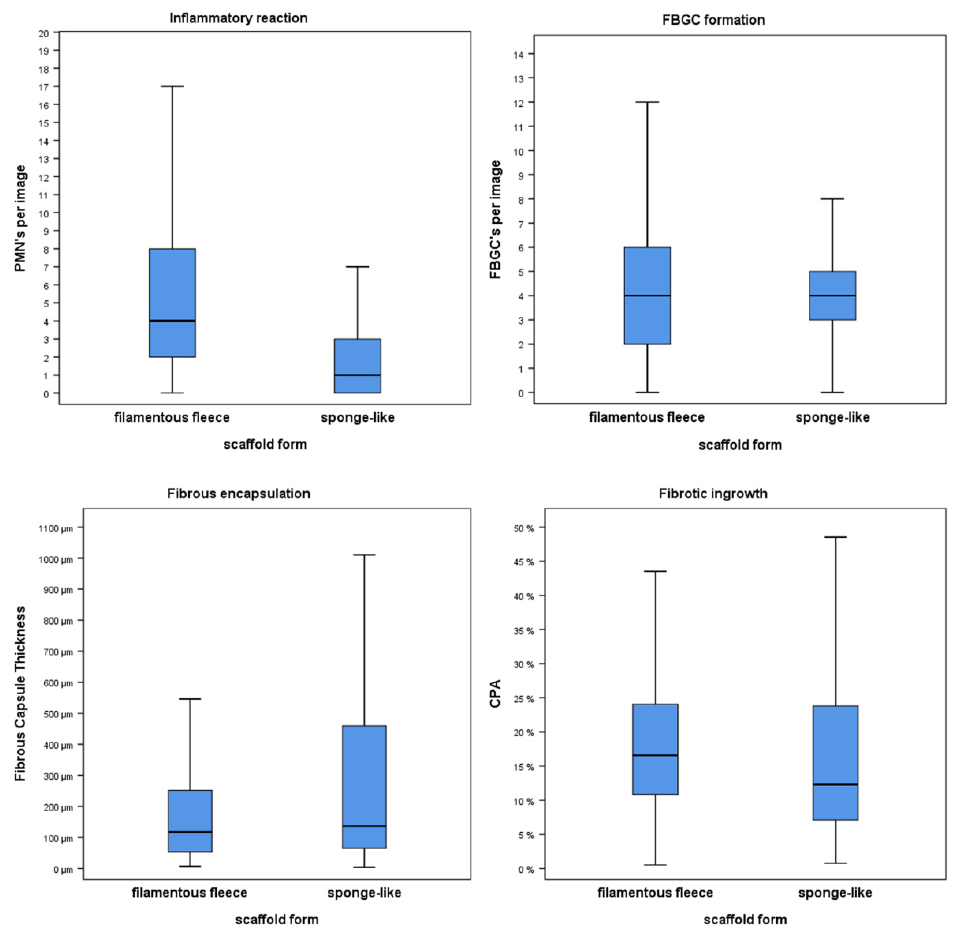
Figure 7. Results of the histopathological comparison between filamentous fleece and sponge-like biomaterial matrices (=scaffolds): variables of the FBR (PMNs, FBGCs, fibrotic encapsulation, fibrotic ingrowth) were quantified and are shown in box plots. Box plots indicate the median and the 5–95% percentiles.